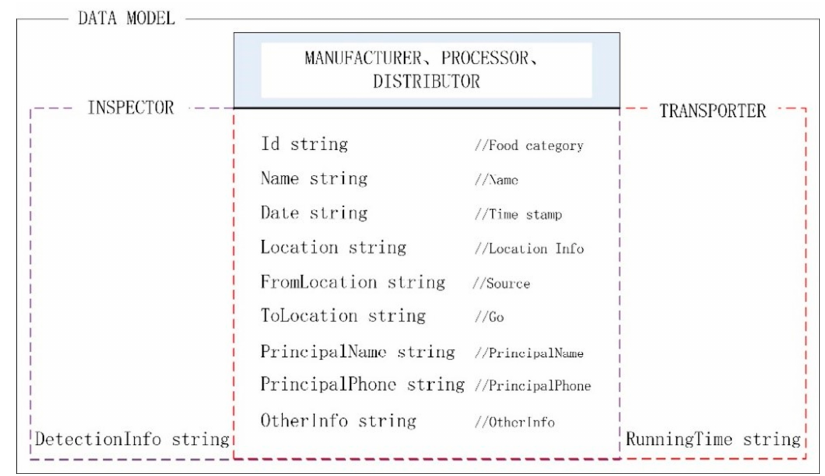
Figure 2. Data structure model for uploading to the blockchain.